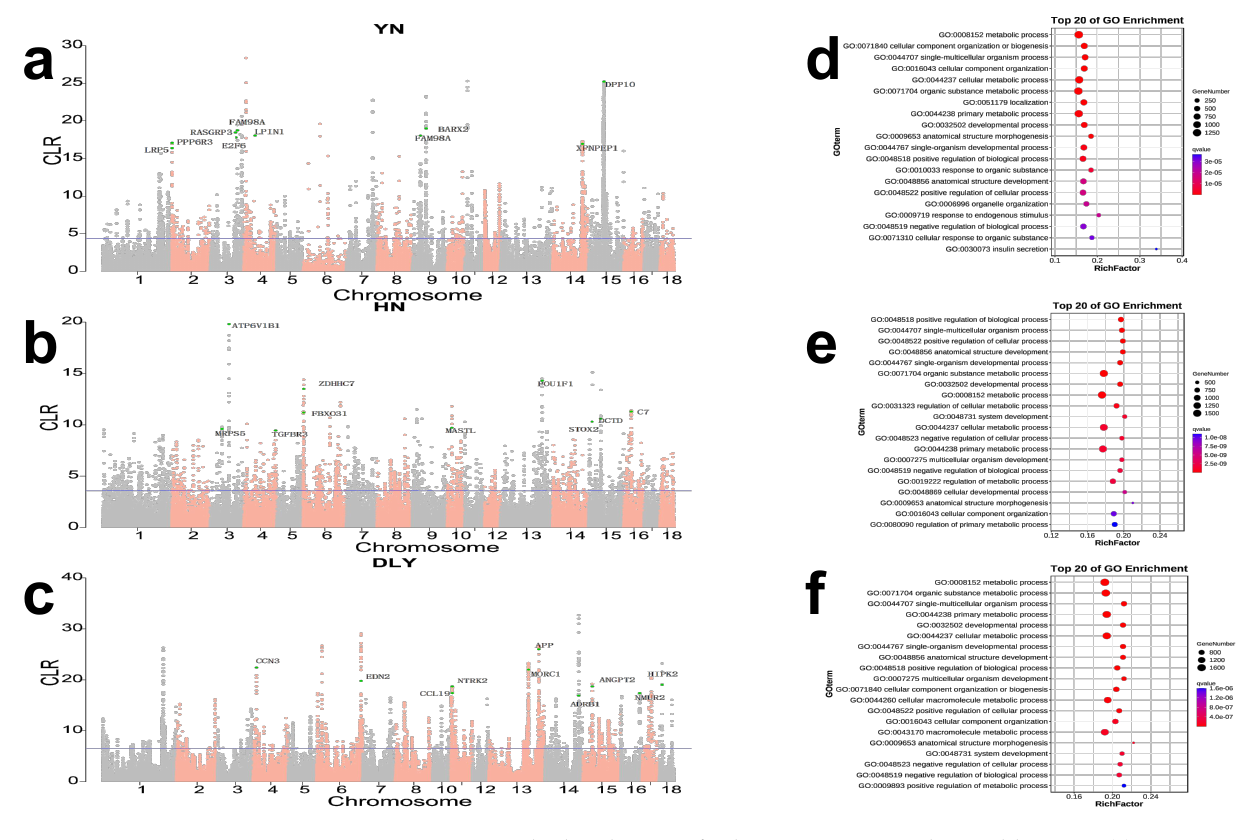
Figure 2. Genome-wide distribution of selection signatures detected by CLR. ( a ) CLR statistics across all autosomes in YN black pigs. ( b ) CLR statistics across all autosomes in HN pigs. ( c ) CLR statistics across all autosomes in DLY pigs. The blue line corresponds to the 99% threshold on the corresponding empirical distributions. ( d – f ) The top 20 GO enrichment analysis of selected genes in YN black pigs, HN pigs and DLY